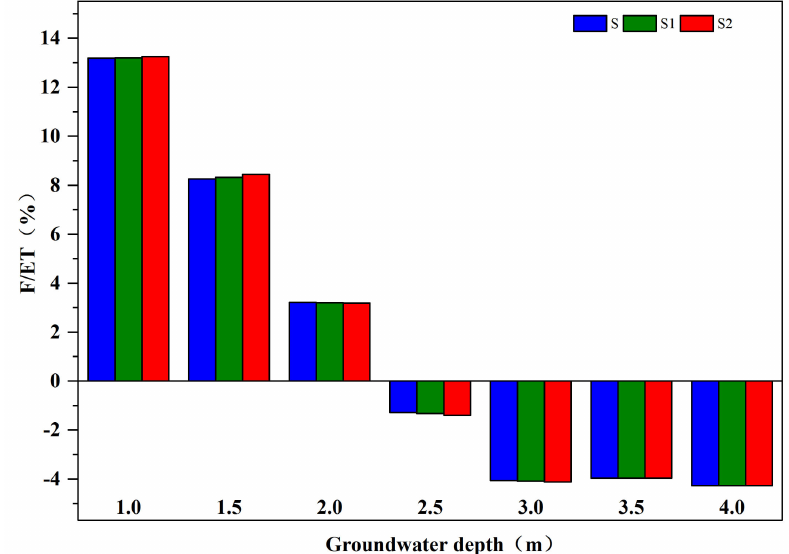
Figure 6. Groundwater contribution to water use (F / ET) during the growing period with groundwater depth ranging from 1 m to 4 m and groundwater salinity ranging from 1 g / L to 4 g / L. Note: S, S1 and S2 refer to the scenarios with groundwater salinity of 1 g / L, 2 g / L and 4 g / L,